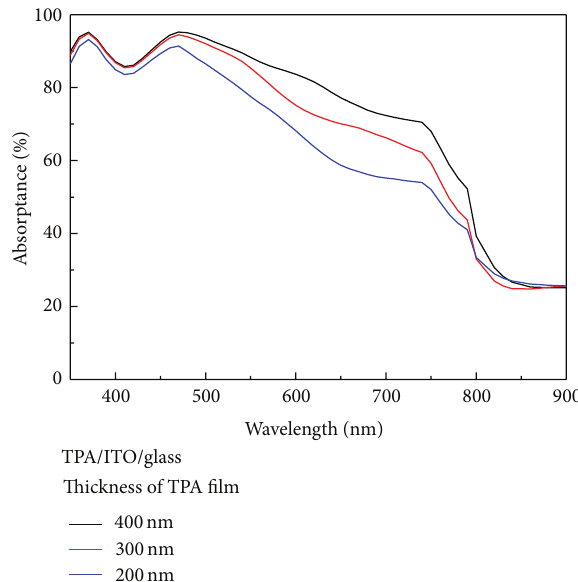
Figure 2: Absorptance spectra of TPA/ITO/glass for different TPA thicknesses.